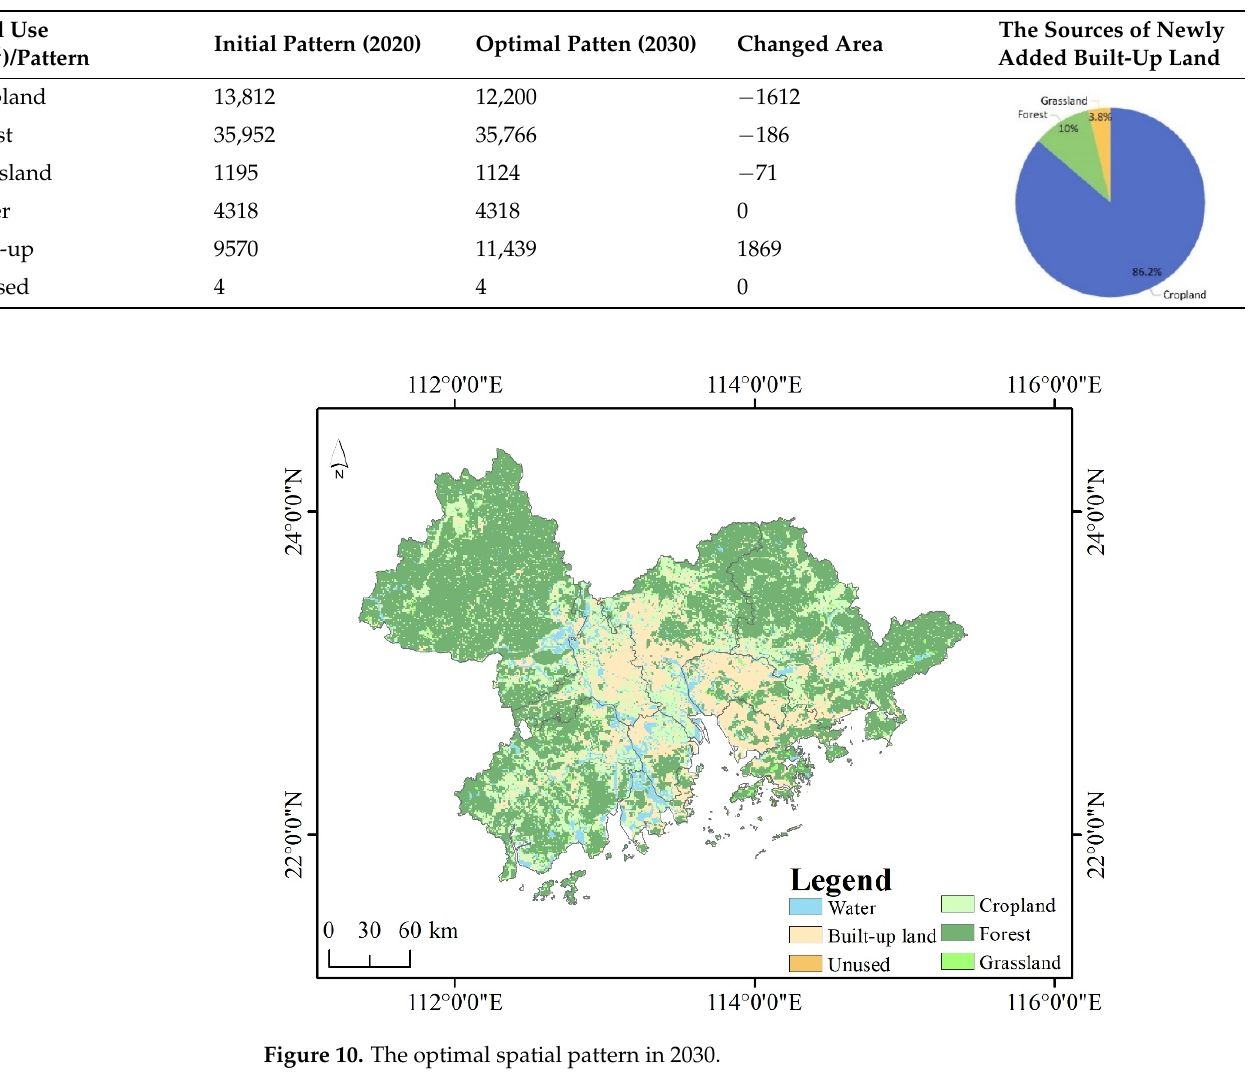
Table 3. The land use change of optimal spatial patterns in 2030.